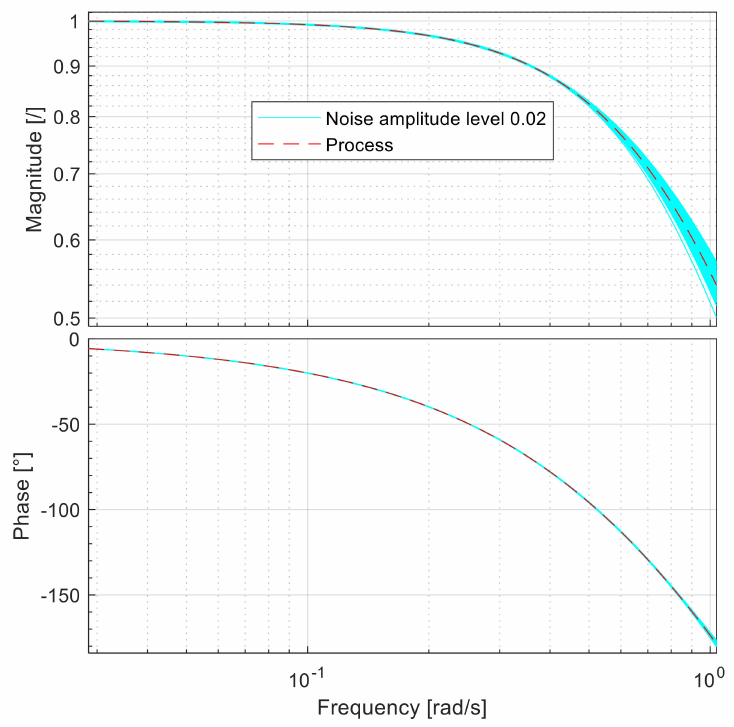
Figure 29. The Bode plots for process G P7